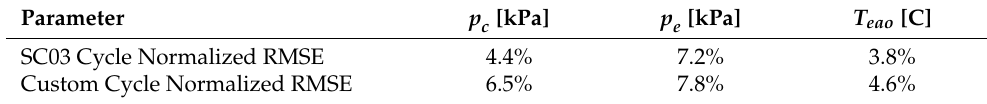
Table 2. Normalized RMSE between VEM and NL models for SC03 and custom cycles.